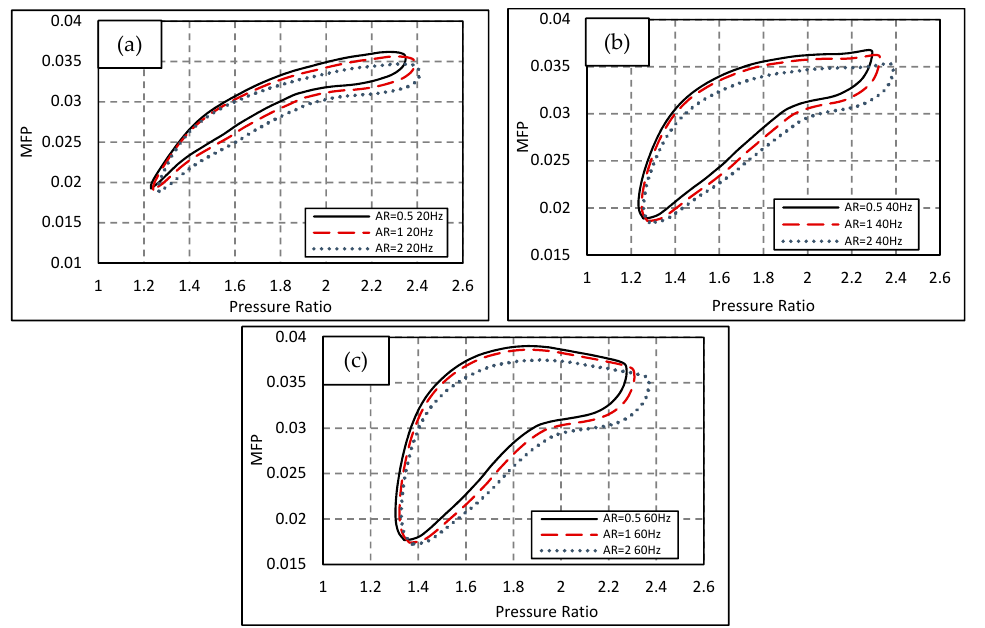
Figure 9. Mass Flow Parameter (MFP) vs. pressure ratio for volute aspect ratio designs with constant A/r . ( a ) 20 Hz; ( b ) 40 Hz and ( c ) 60 Hz.